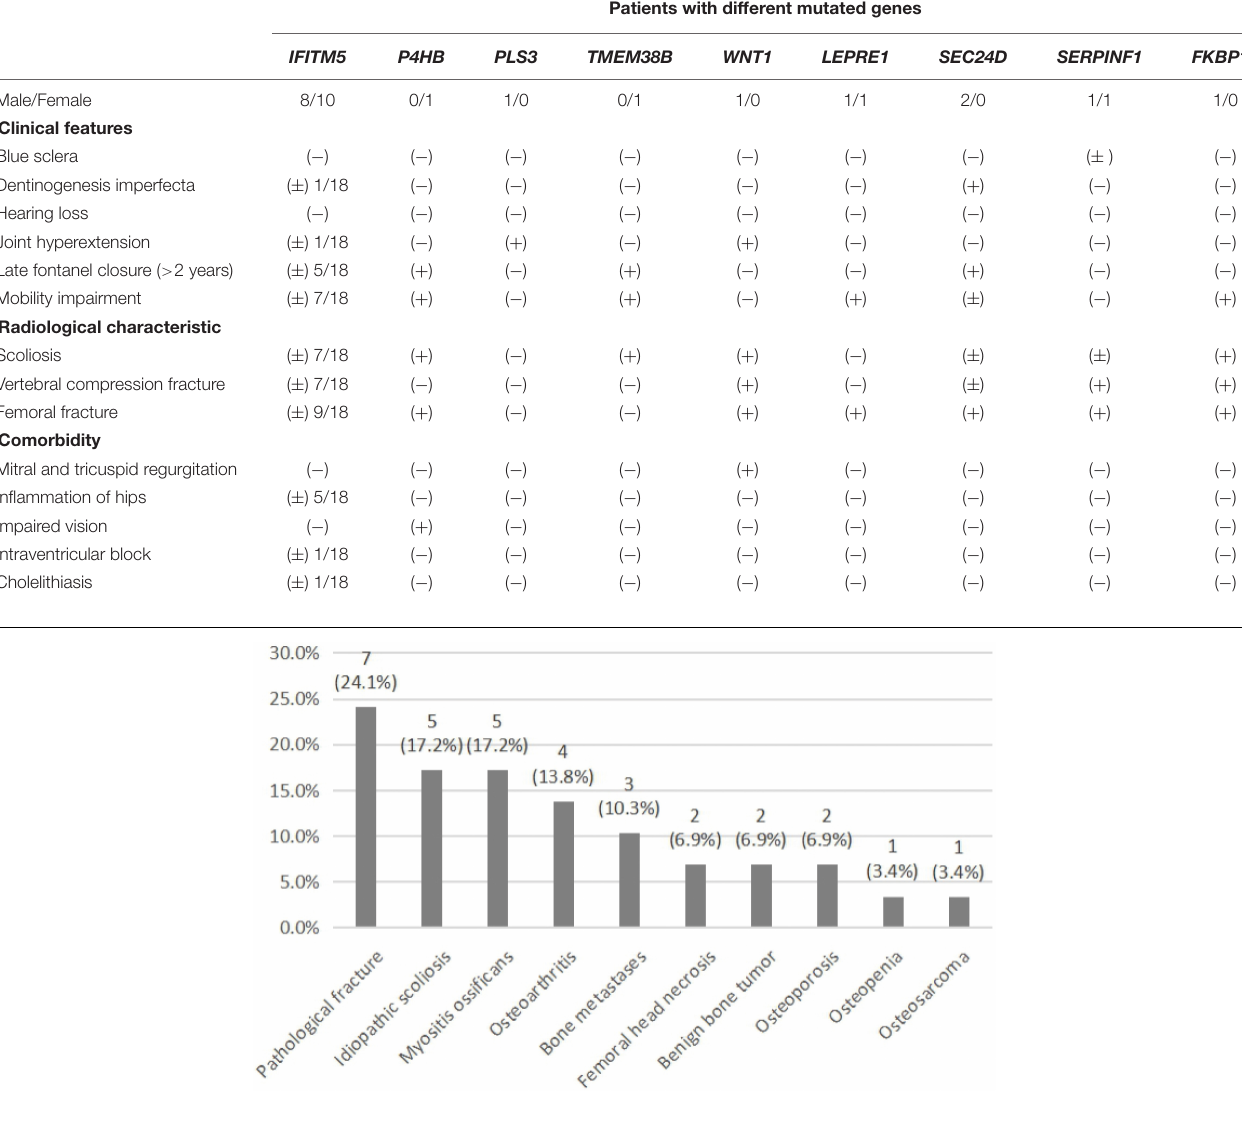
TABLE 2 | Summary of clinical, radiological features, and comorbidity with rare types of OI.